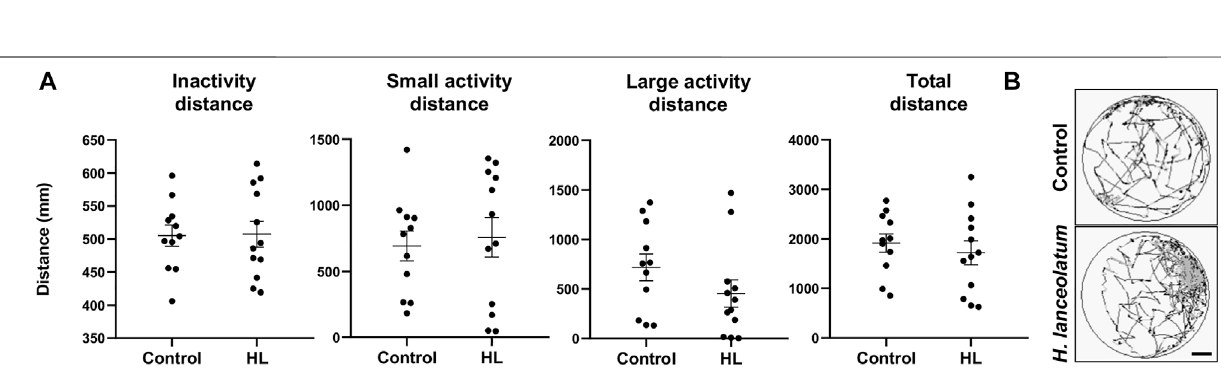
FIGURE 4 | H. lanceolatum aqueous extract did not impact the behavioral activity in larvae. (A) Graphs showed the inactivity, small activity, large activity and total distances of 6-dpf larvae after 3 days of incubation with the H. lanceolatum aqueous extract at the MNTC (HL) or E3 medium (Control) (B) Total distance of control and treated larvae. Individual values were represented with means ± SEM ( n = 11 – 12 animals/group). Bar = 2.3